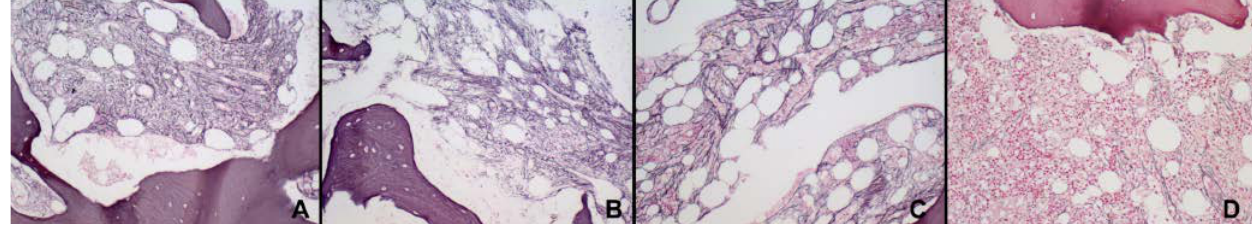
Figure 1. Grading of bone-marrow fibrosis (MF) according to the WHO guidelines using the Gomori stain. MF was evaluated: A) before the unrelated allogeneic HSCT, B) before the haploidentical HSCT, C) on day +90 and D) on day +180 following the hap- loidentical HSCT. Final magnification